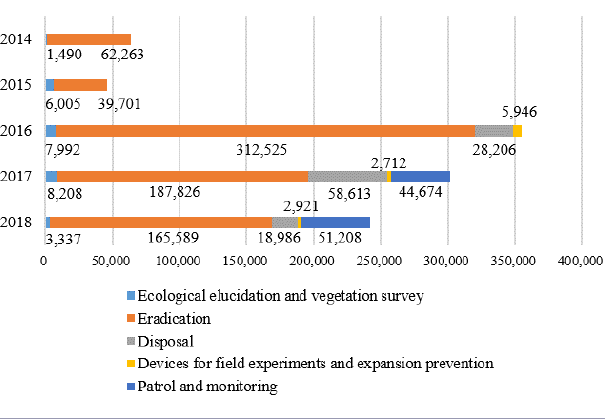
Fig. 4 . Total annual expenditure by the Lake Biwa Special Council for Invasive Aquatic Plants (thousand Japanese